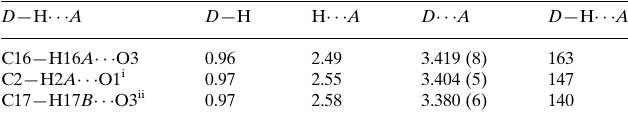
Hydrogen-bond geometry (A˚ , (cid:2)